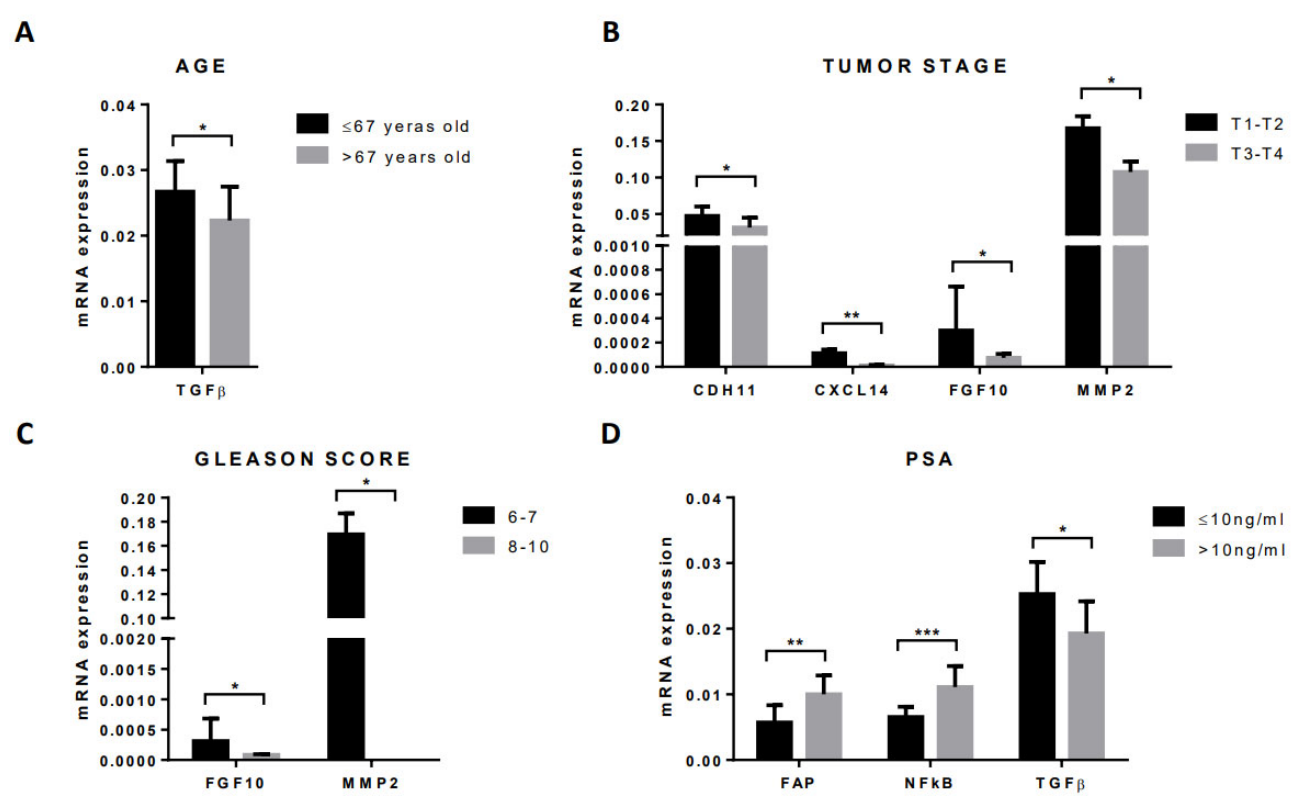
Figure 5. Gene expression of stromal factors by CAFs according to clinical–pathological character ‐ istics of prostate carcinomas, ( A ) age, ( B ) tumor stage, ( C ) Gleason score, and ( D ) PSA level. * p ≤ 0.05; ** p < 0.01; *** p < 0.001. ** p < 0.01; *** p <